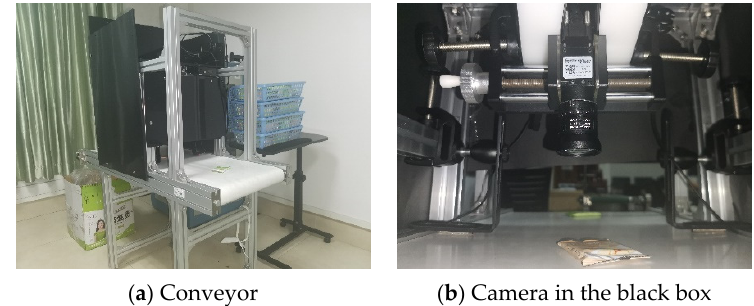
Figure 1. Conveyor